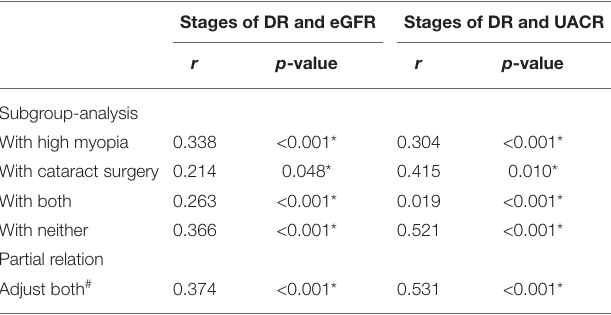
NPDR, OR = 3.955, p = 0.005; severe NPDR, OR = 6.836, p < 0.001; PDR, OR = 9.756, p < 0.001).